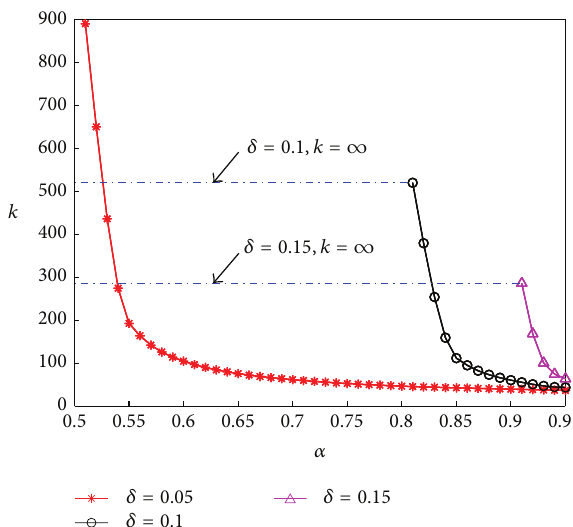
Figure 5: Correlation between 𝑘 and 𝛼 with given different 𝛿 .